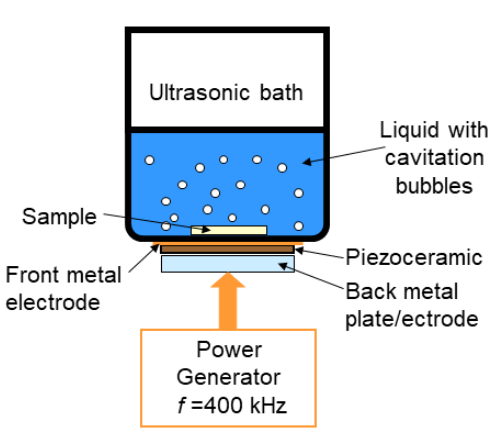
Figure 1. Schematics of the setup used for sonication at about 400 kHz.